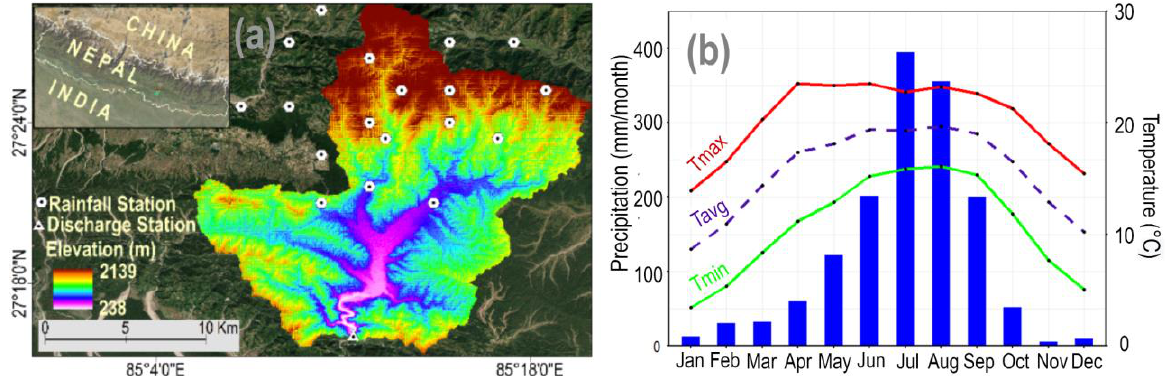
Figure 2. ( a ) Location of Simat Khola River Basin (SKRB), Nepal with physiography and selected ground-based to observed precipitation points; ( b ) climatograph of study basin for 16 years from 2003 to 2018. The bar diagram denotes the mean of seasonal monthly accumulated rainfall, and red solid, blue dotted, and solid green lines represent the monthly maximum, average, and minimum temperature, respectively.